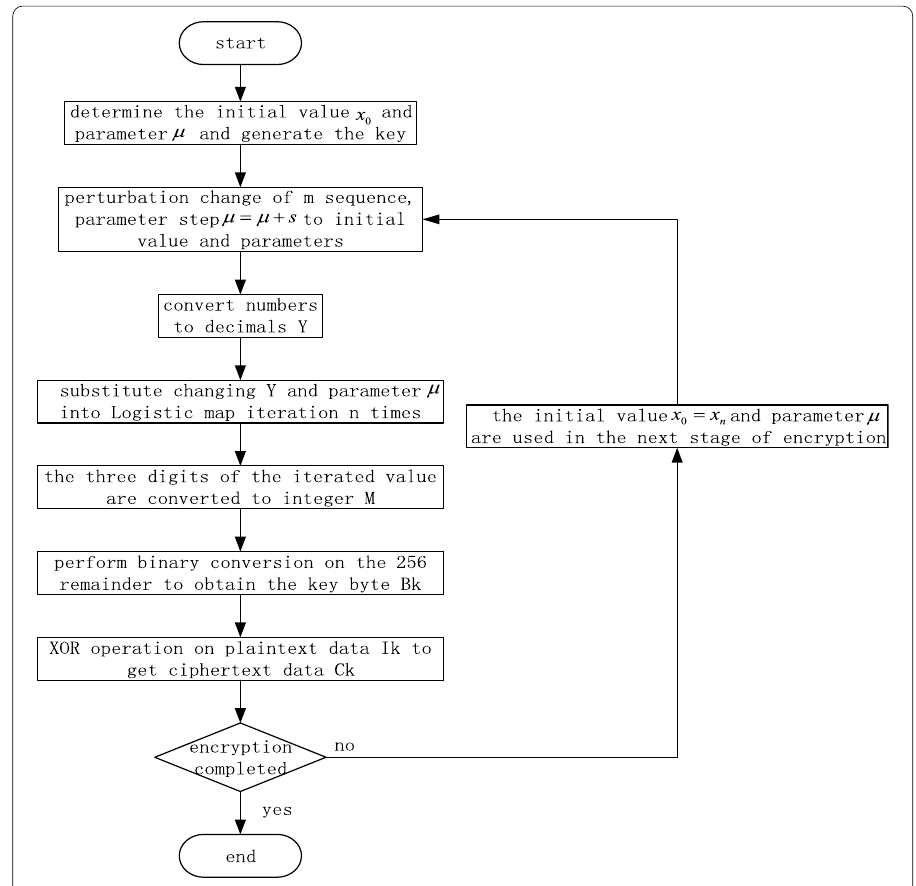
Fig. 5 Improved algorithm operation